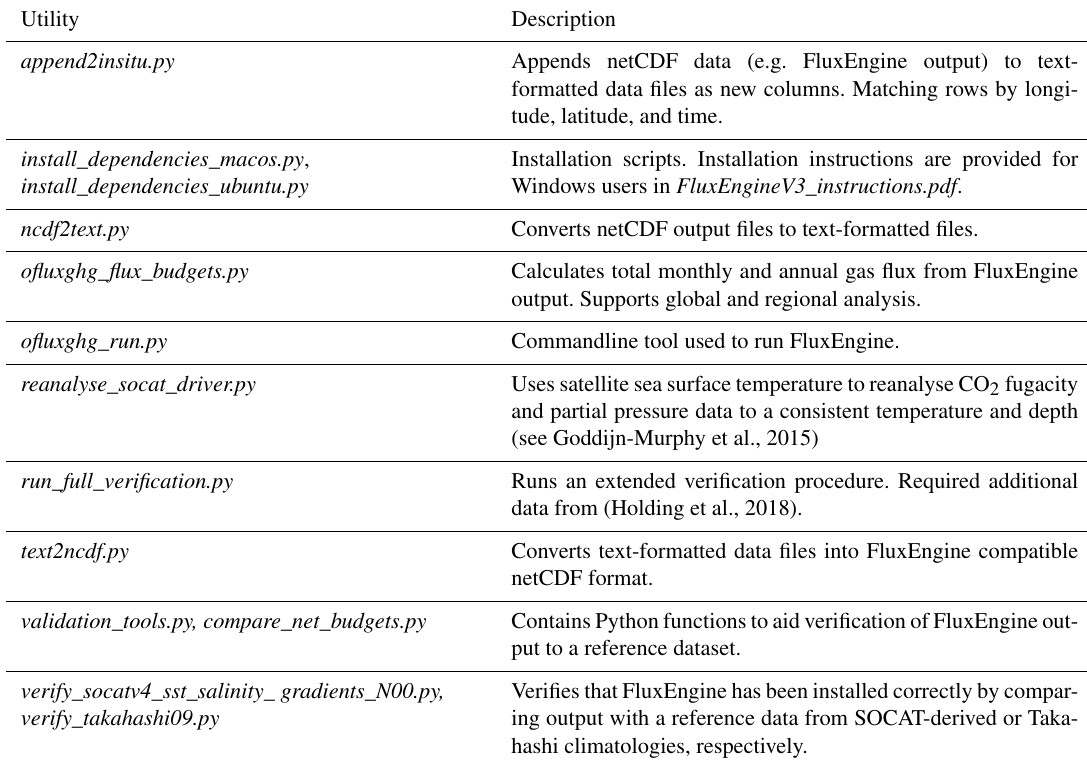
Table A1. Description of the bundled tools and scripts that are included in FluxEngine. Each tool can be used as a stand-alone command-line tool or used as a Python